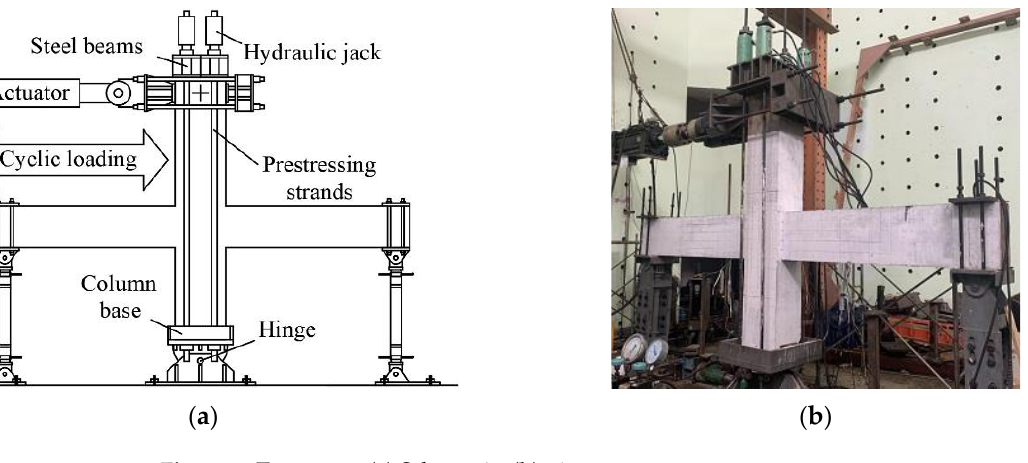
controlled lateral loading sequence was employed in this test according to ACI 374.1-05 [28].